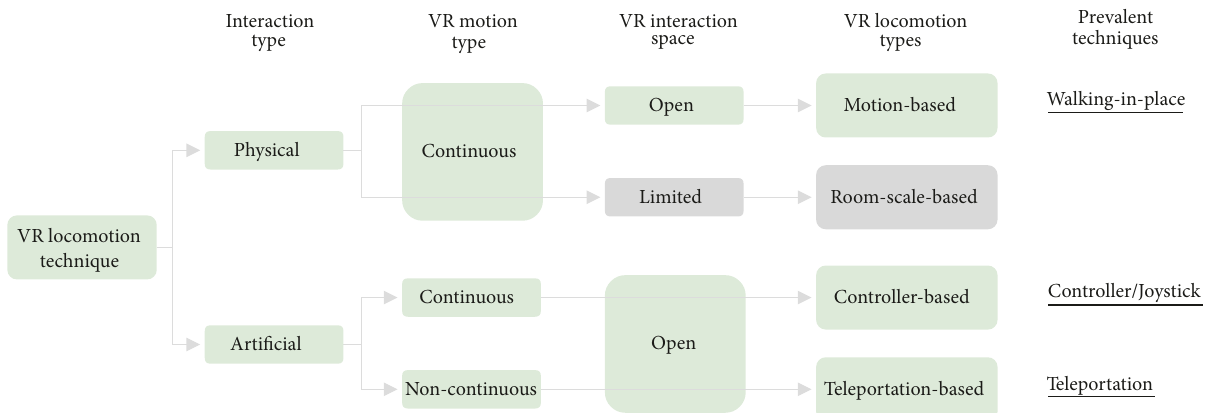
Figure 1: The typology of VR locomotion techniques [5]. The VR locomotion types and interaction aspects represented in the empirical comparison (in green boxes), leading up to the three identified, prevalent techniques.